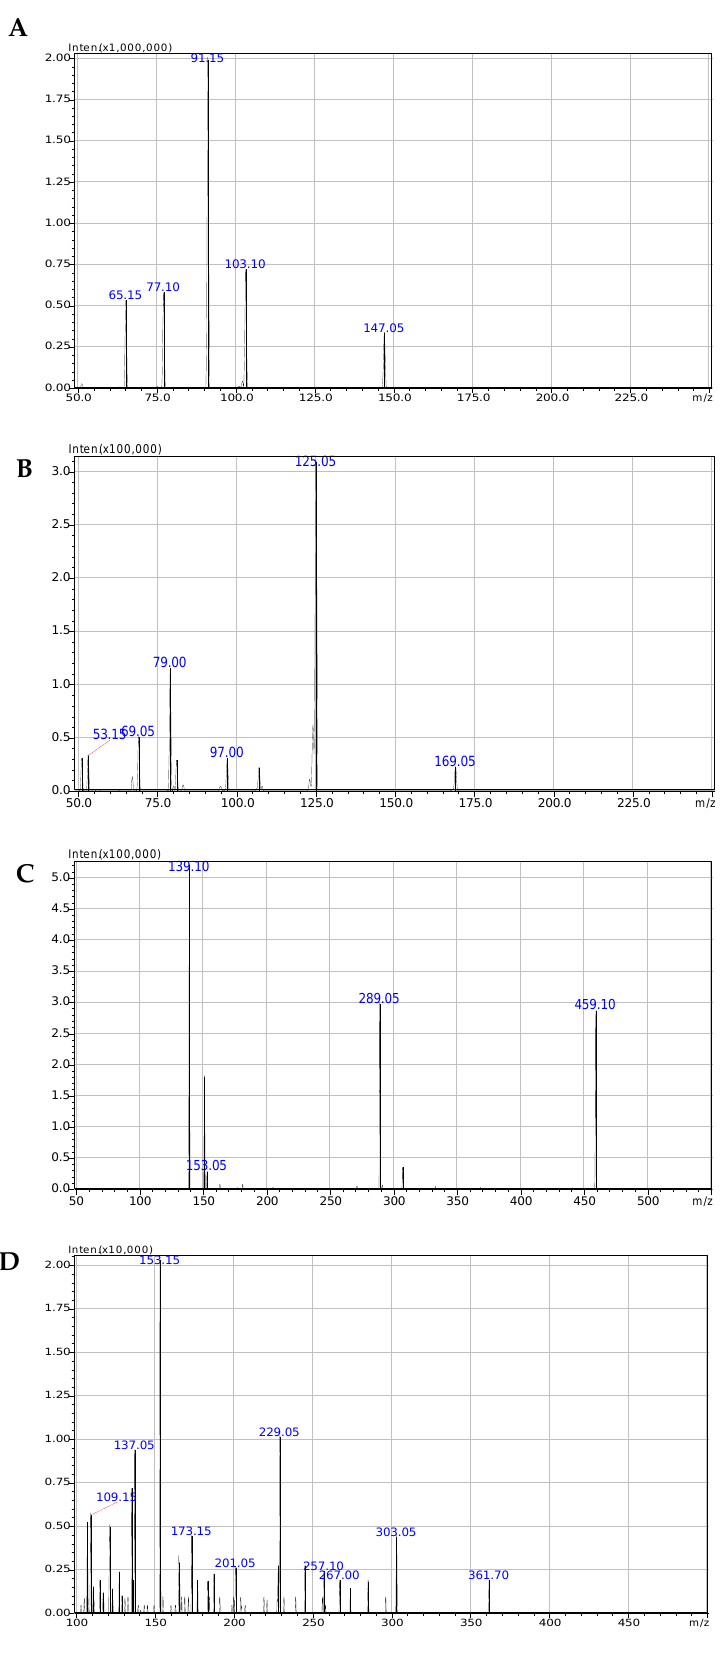
Figure 4. LC–MS/MS analysis presenting the precursor ion and product ion spectra of ( A ) coumarin, ( B ) gallic acid, ( C ) EGCG, and ( D )